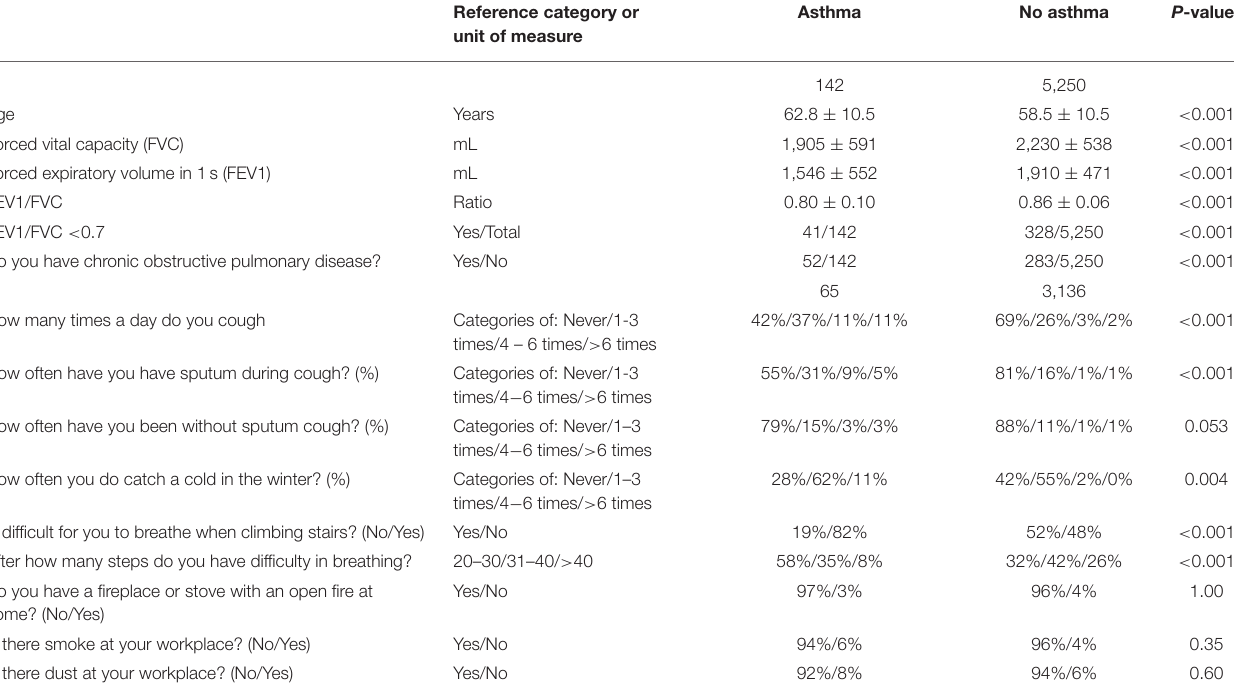
TABLE 6 | Spirometric measurements and clinical signs of asthma (mean ± standard deviations; frequency; and 95% confidence intervals) in the Ural Eye ad Medical Study stratified by the presence of